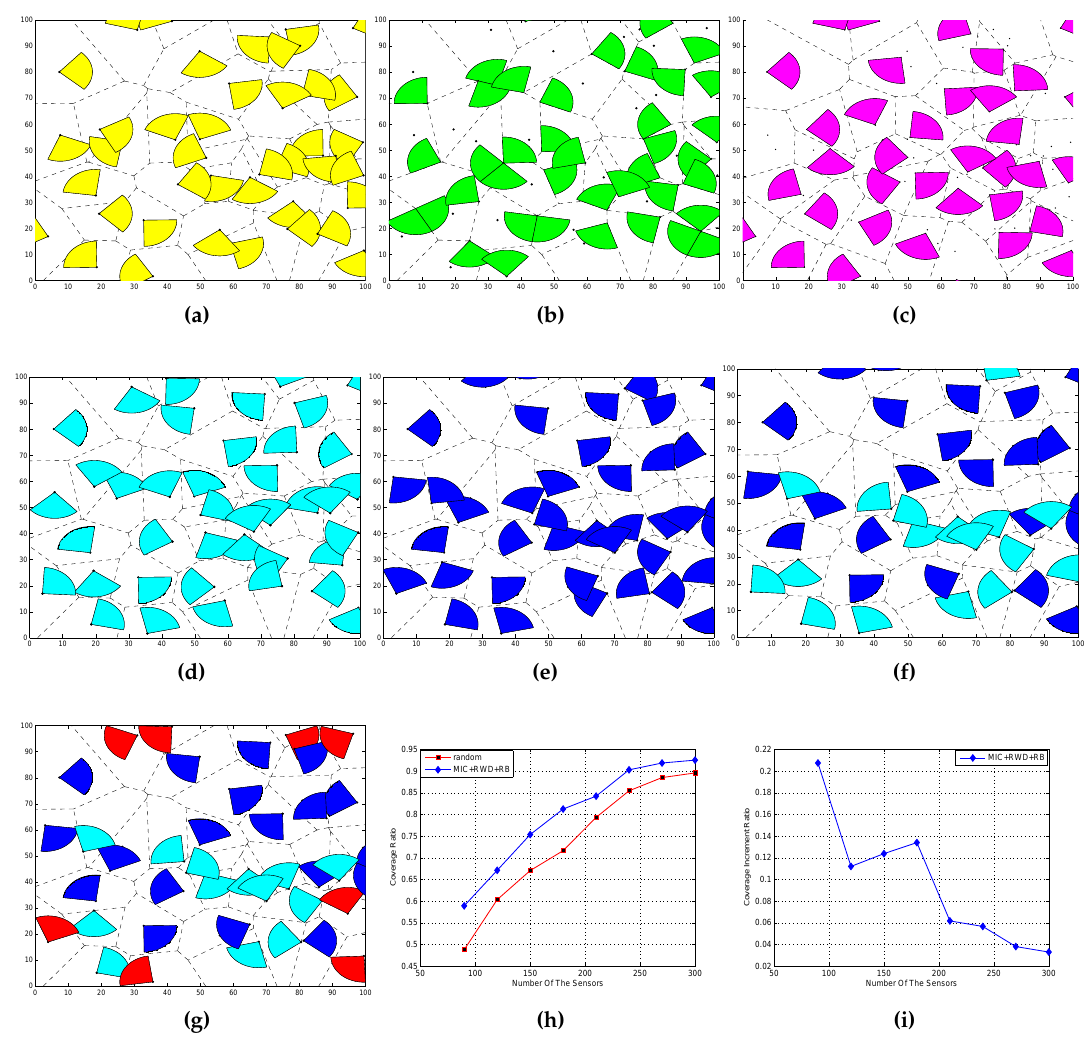
Figure 7. Coverage. ( a ) random; ( b ) DVSA; ( c ) EDA-II; ( d ) RWD; ( e ) MIC; ( f ) MIC and RWD; ( g ) MIC + RWD + RB; ( h ) Coverage ratio with R s = 10, AoV = 90 ◦ ; ( i ) Coverage increment ratio with R s = 10, AoV = 90 ◦